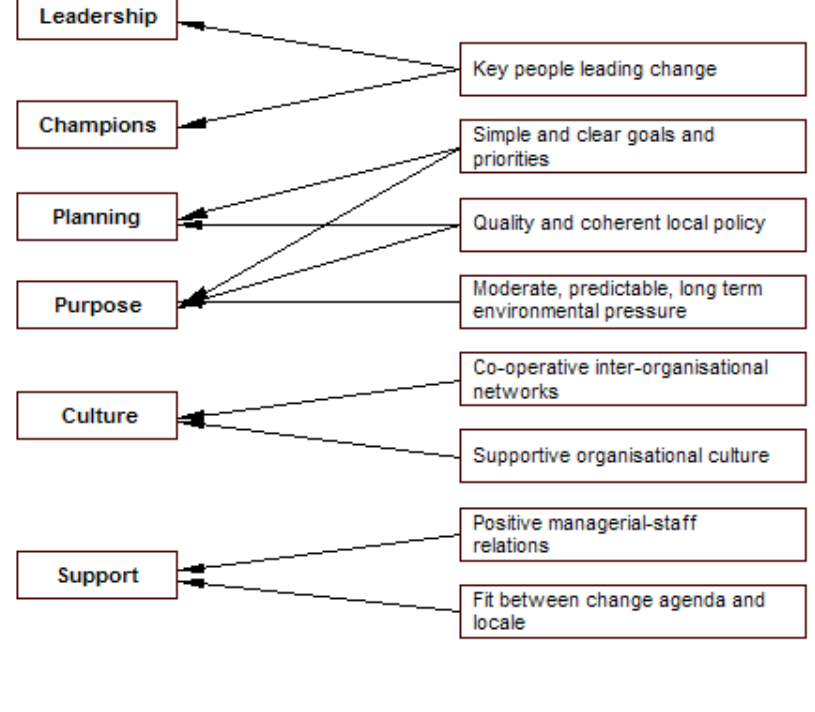
Figure 2. Mapping of CCP Success Factors on Characteristics of